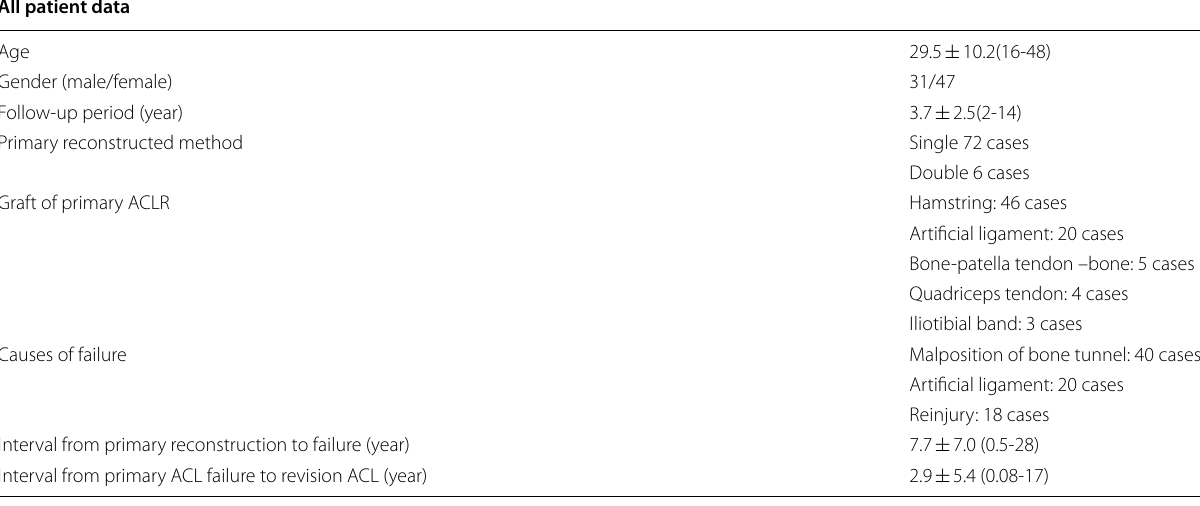
Table 1 Data of all included patients